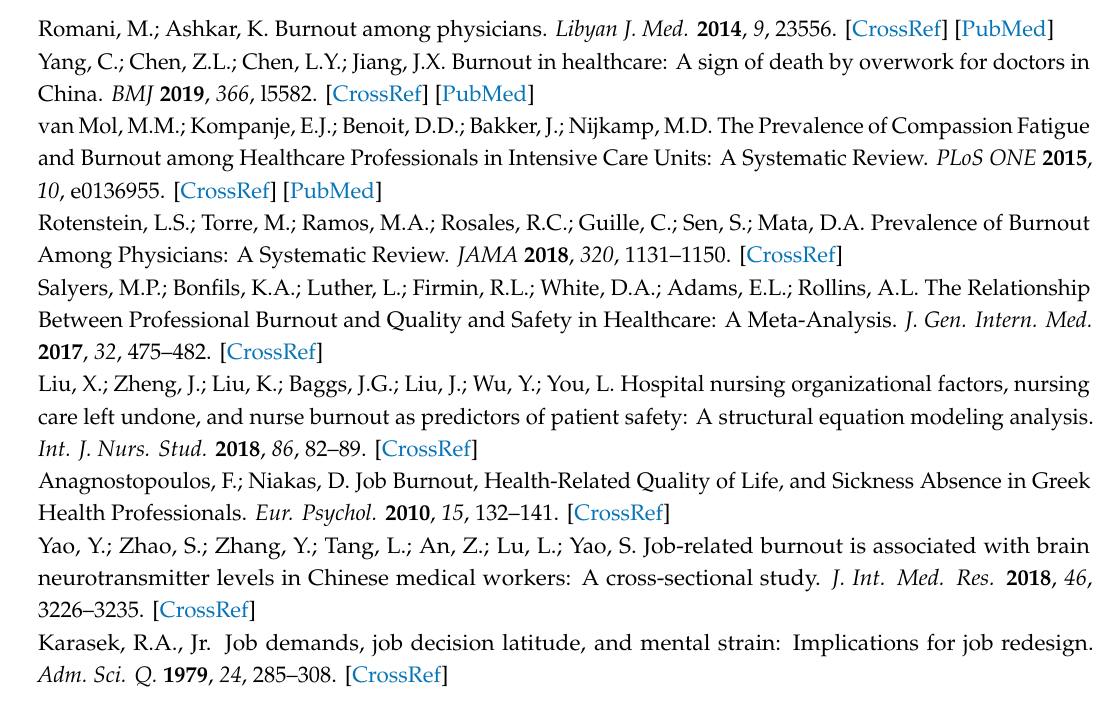
Table S1: The Chinese version of Scale for occupational stressors on clinicians, Table S2: Details of items in each domain in the Scale for occupational stressors on